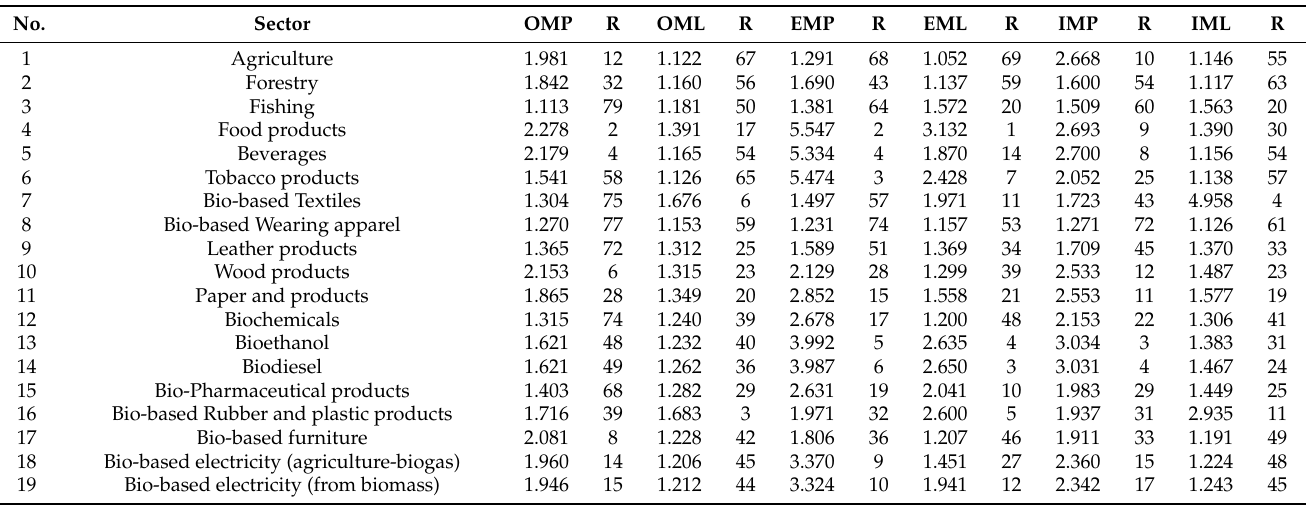
Table 3. Input–output multipliers of the Polish and Lubelskie Region bioeconomy sectors (output, employment, and